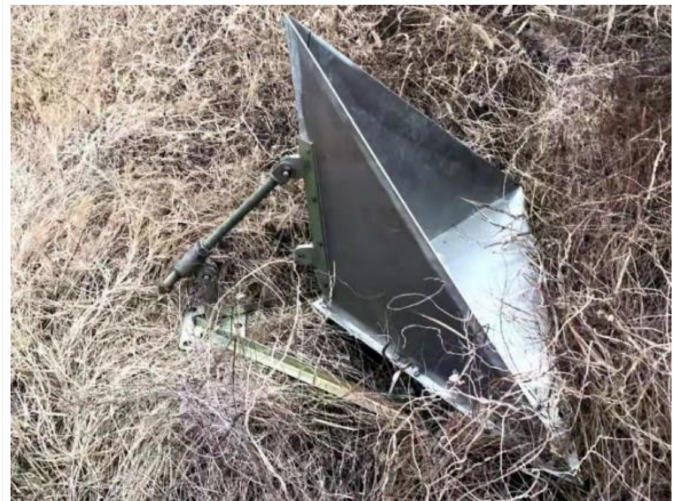
Figure 2. Triangular trihedral corner reflector used in the experiment.